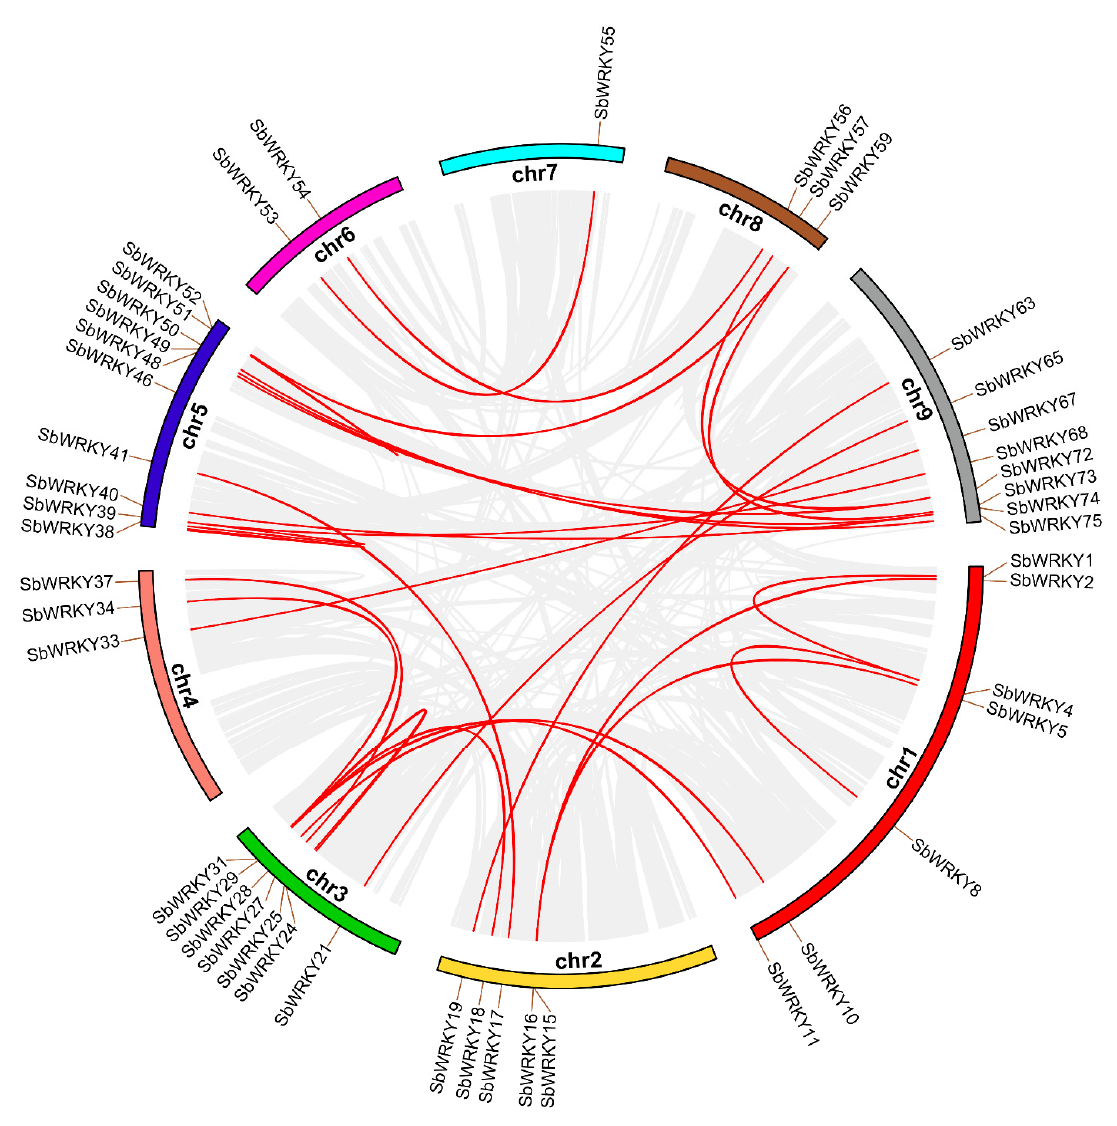
Figure 6. Synteny analysis of interchromosomal relationships of SbWRKY genes. All gene pairs and SbWRKY gene pairs in the S. baicalensis genome were indicated by gray lines and red lines, respec ‐ tively.